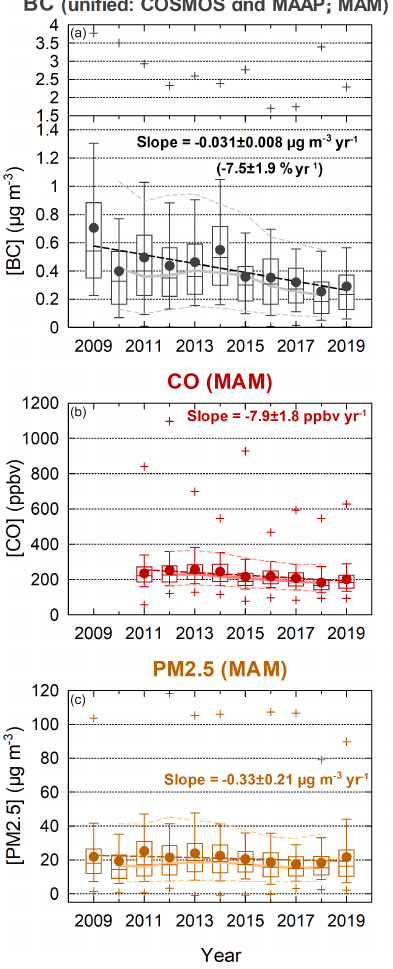
Figure 3. Statistics of the observed black carbon (BC) mass concen- trations, CO mixing ratio, and fine particulate matter (PM 2 . 5 ) mass concentrations during spring (MAM) from 2009 to 2019. Averages (dots), interquartile range (open boxes), 10th to 90th range (error bars), medians (horizontal whiskers), and maximum and minimum hourly values (plus signs). The 3-year running means are from 2010 to 2018 for the medians, and the 10th and 90th percentiles are shown with connected solid and/or dotted lines. The regression lines for the 3-year running means for the averages are shown as broken lines. The BC measurements are from the continuous soot monitor- ing system (COSMOS) and a Multi-Angle Absorption Photometer (MAAP).